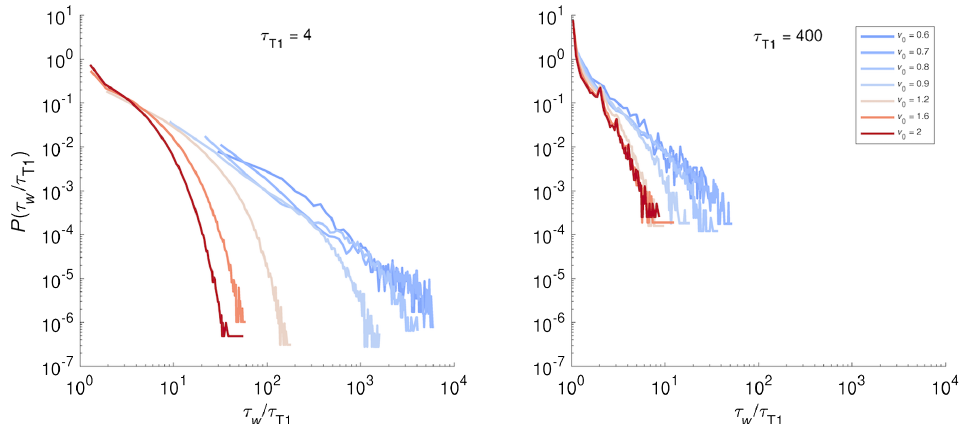
values. The distributions at small τ and v 0 near glass transition are much T 1 T 1 value. The colors follow the T 1